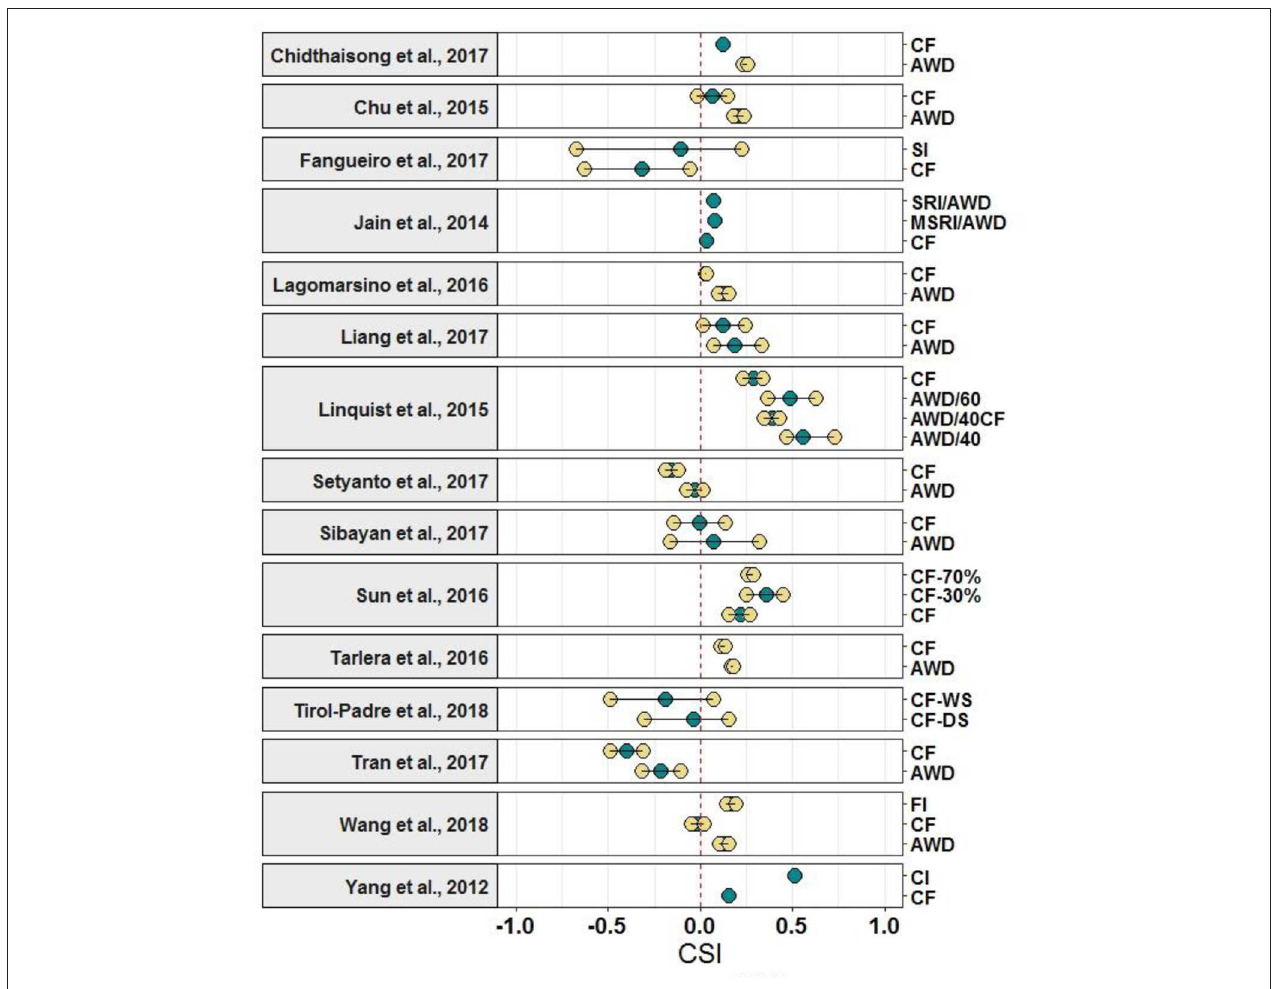
FIGURE 2 | CSI scores of the selected studies. Yellow circles represent max and min CSI values in the studies and green circles represent the CSI average. The labels in the right axis indicate the water management treatments that were assessed. CF, Continuous Flooding; CF-70%, 70% of normal irrigation; CF-30%, 30% of normal irrigation; AWD, Alternate Wetting and Drying; AWD/60, AWD treatments were irrigated until soil moisture reached 60% of saturated volumetric water–measured at 5cm depth when the plots were re-flooded; AWD/40, AWD treatments were irrigated until soil moisture reached 40% of saturated volumetric water–measured at 5cm depth when the plots were re-flooded; AWD/40CF, AWD treatments were irrigated until soil moisture reached 40% of saturated volumetric water–measured at 5cm depth when the plots were re-flooded, up until the plants reached the reproductive growth stage; after which a flood was maintained up until the field was drained for harvest; CI, Controlled Irrigation; SI, Sprinkler irrigation; CF-WS, Continuous Flooding during Wet Season; CF-DS, Continuous Flooding during Dry Season; FI, Furrow Irrigation; SRI/AWD and MSRI/AWD, Irrigation was given on twice a week to keep soil just moist